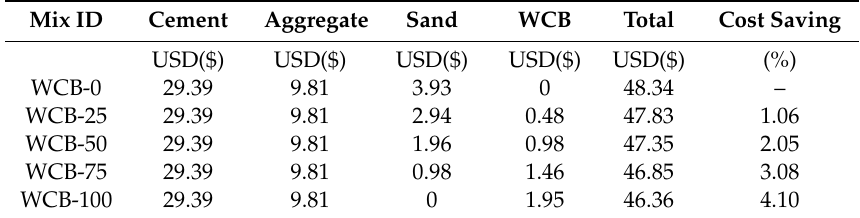
Table 8. Cost analysis for 1 m 3 concrete produced using waste carbon black.